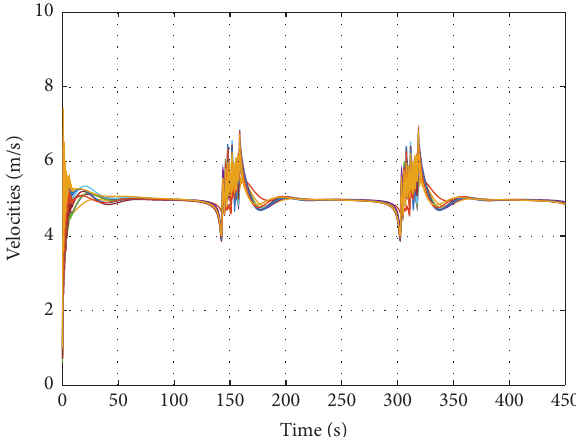
Figure 5: The evolution of all the vehicle velocities v